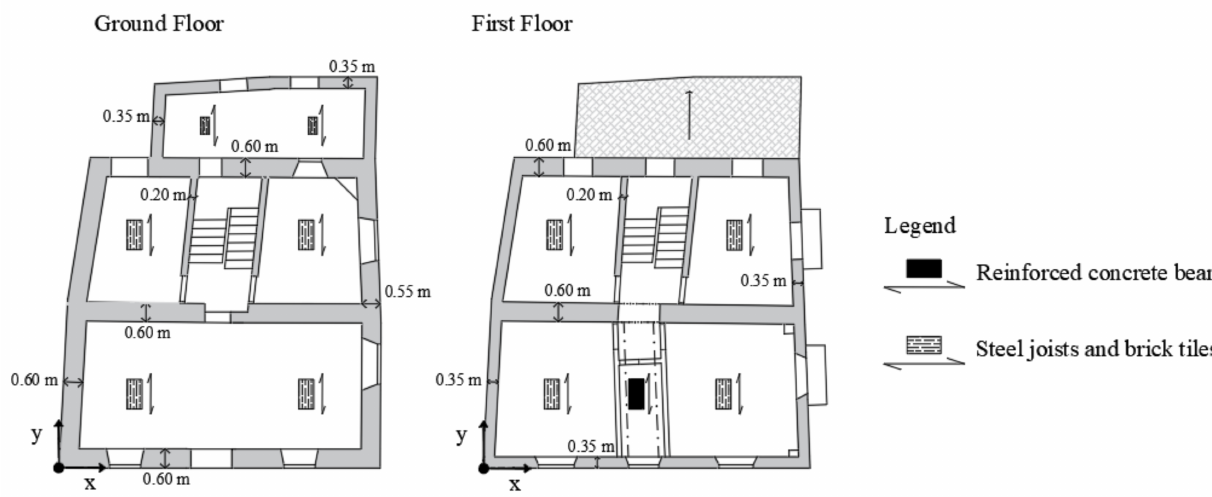
Figure 1. Plans of the building with the indication of the warping of horizontal